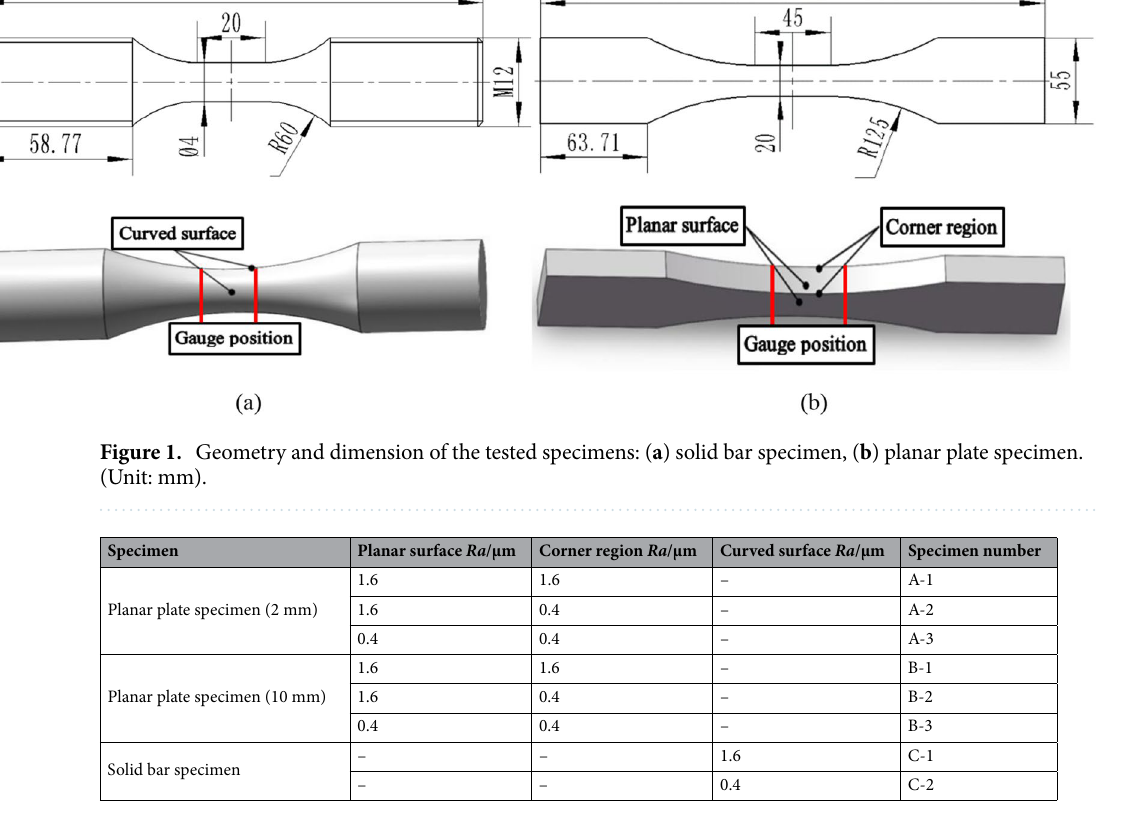
Table 2. 8 groups of specimens with different roughness